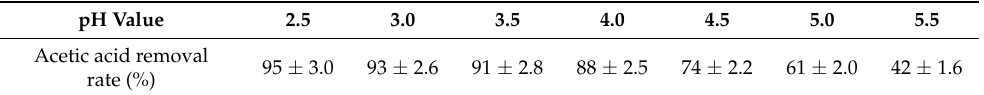
Table 3. Effect of different pH values on the acetic acid removal rate.